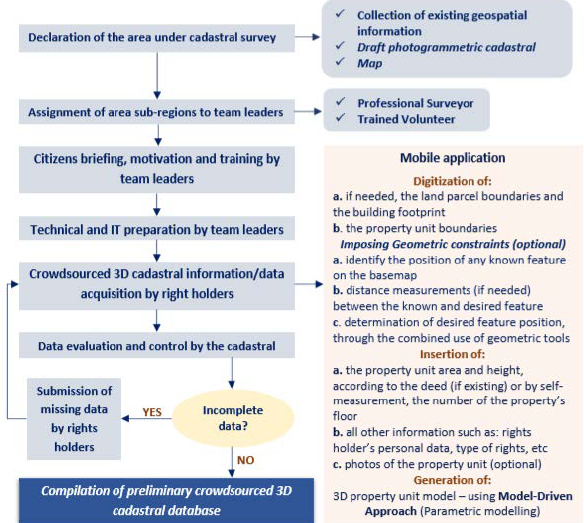
Figure 1. Proposed methodology for 3D crowdsourced cadastral surveys up to the stage of the compilation of the preliminary 3D cadastral maps and data